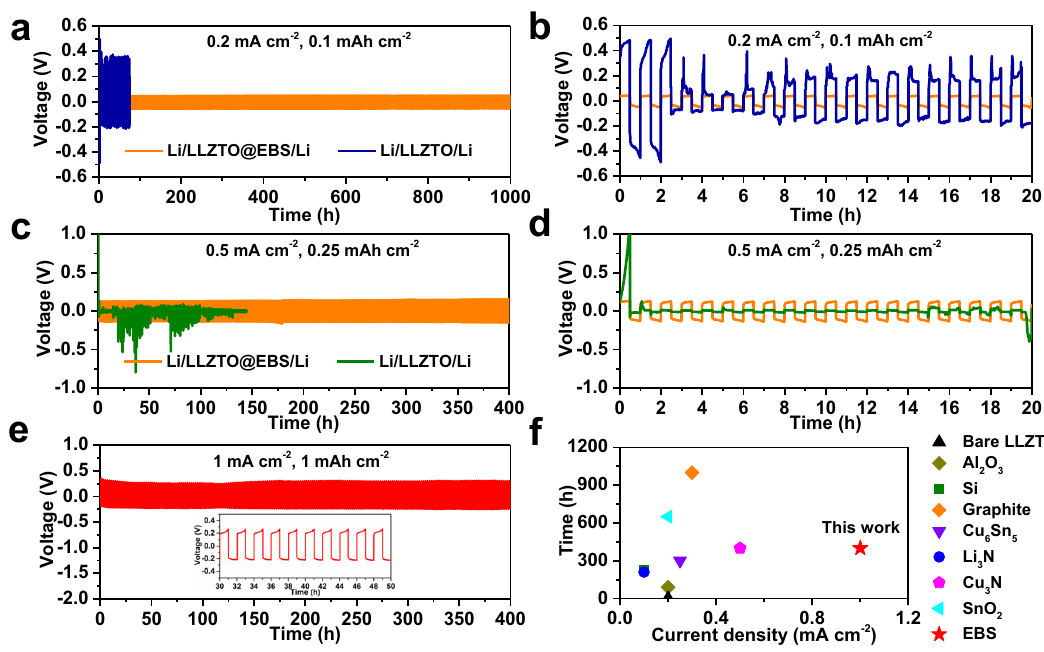
Fig. 4 Electrochemical performance of Li symmetric cells using bare LLZTO and the PAA-modi fi ed LLZTO. a Galvanostatic cycling performance of the Li/LLZTO/Li and Li/LLZTO@EBS/Li cells at 0.2 mA cm − 2 (0.1 mAh cm − 2 ) at 25 °C; b Magni fi ed images for 0 – 20 h. c Galvanostatic cycling performance of the Li/LLZTO/Li and Li/LLZTO@EBS/Li cells at 0.5 mA cm − 2 (0.25 mAh cm − 2 ) at 25 °C; d Magni fi ed images for 0 – 20 h. e Galvanostatic cycling performance of the Li/LLZTO@EBS/Li cell at 1 mA cm − 2 (1 mAh cm − 2 ) at 25 °C. f Galvanostatic cycling performance in recent literature compared with our work 20,21,28,35,37,58,59 .